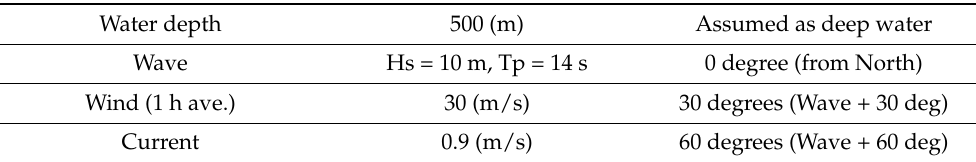
Table 2. Environmental conditions for the ULS